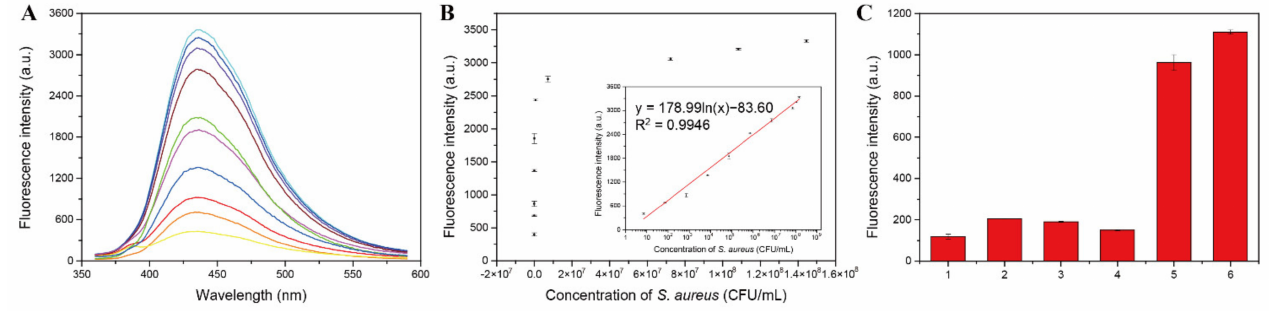
Figure 7. Fluorescent responses of the developed biosensor toward varied concentrations of bacteria cells. ( A ) The fluorescence spectra of the detection system challenged with 7.22 to 1.44 × 10 9 CFU/mL of S. aureus cells; ( B ) Calibration curve for S. aureus detection with blank control and 7.22 to 1.44 × 10 9 CFU/mL; ( C ) The fluorescence intensity detected by different bacteria (The number of 1 to 6 referred to E. coli O157:H7, MRSA , V. parahaemolyticus , S. Typhimurium , S. aureus , and a mixture of all the above bacteria) at the same concentration of about 10 3 CFU/mL.